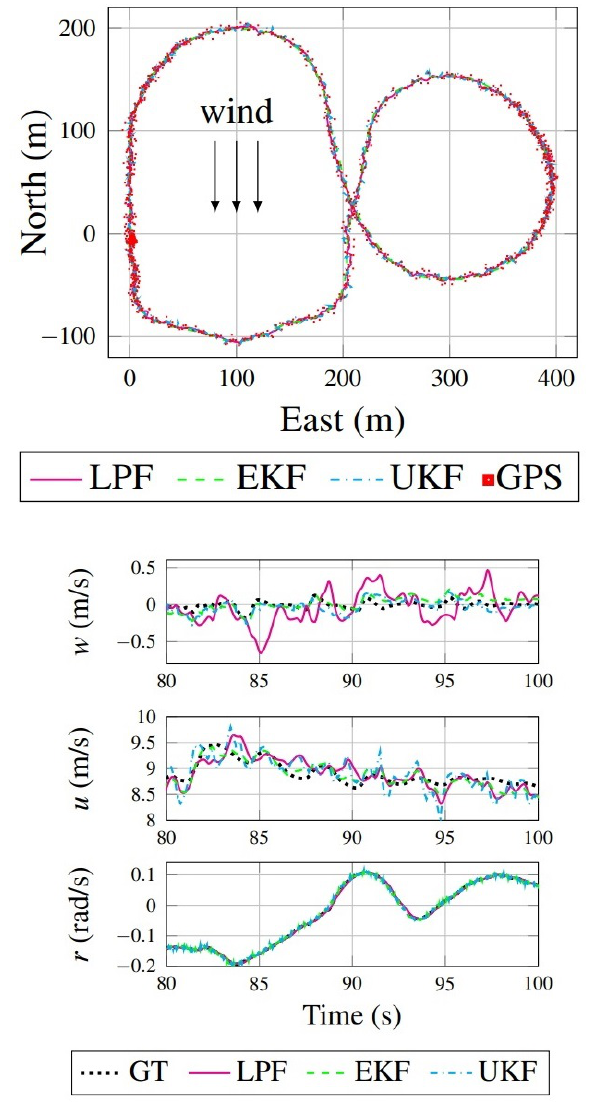
Figure 3. Estimated trajectory ( above ); Estimated vertical velocity ( w ), longitudinal velocity ( u ) and angular velocity ( r ) ( down